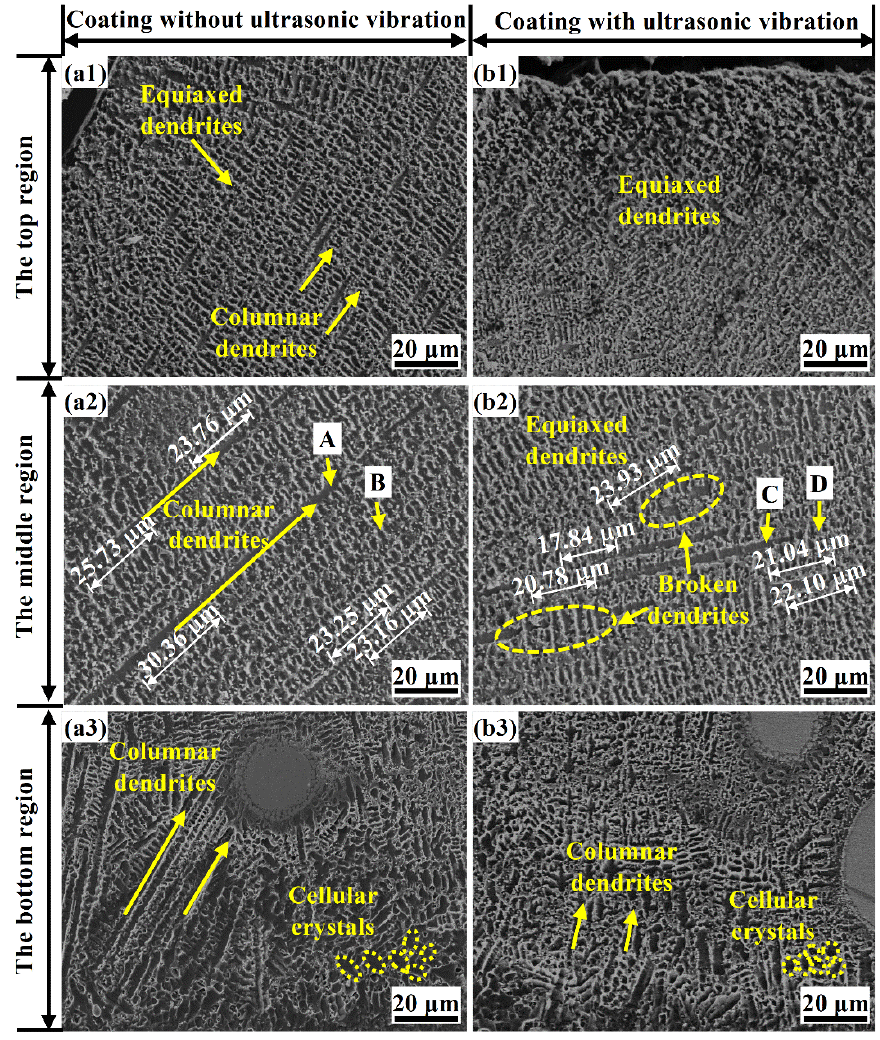
Figure 5. Cross-sectional SEM microstructure of the coatings (a1-a3) without ultrasonic vibration and (b1–b3) with ultrasonic vibration; 1, 2, and 3 represent the top region, middle region and bottom region.